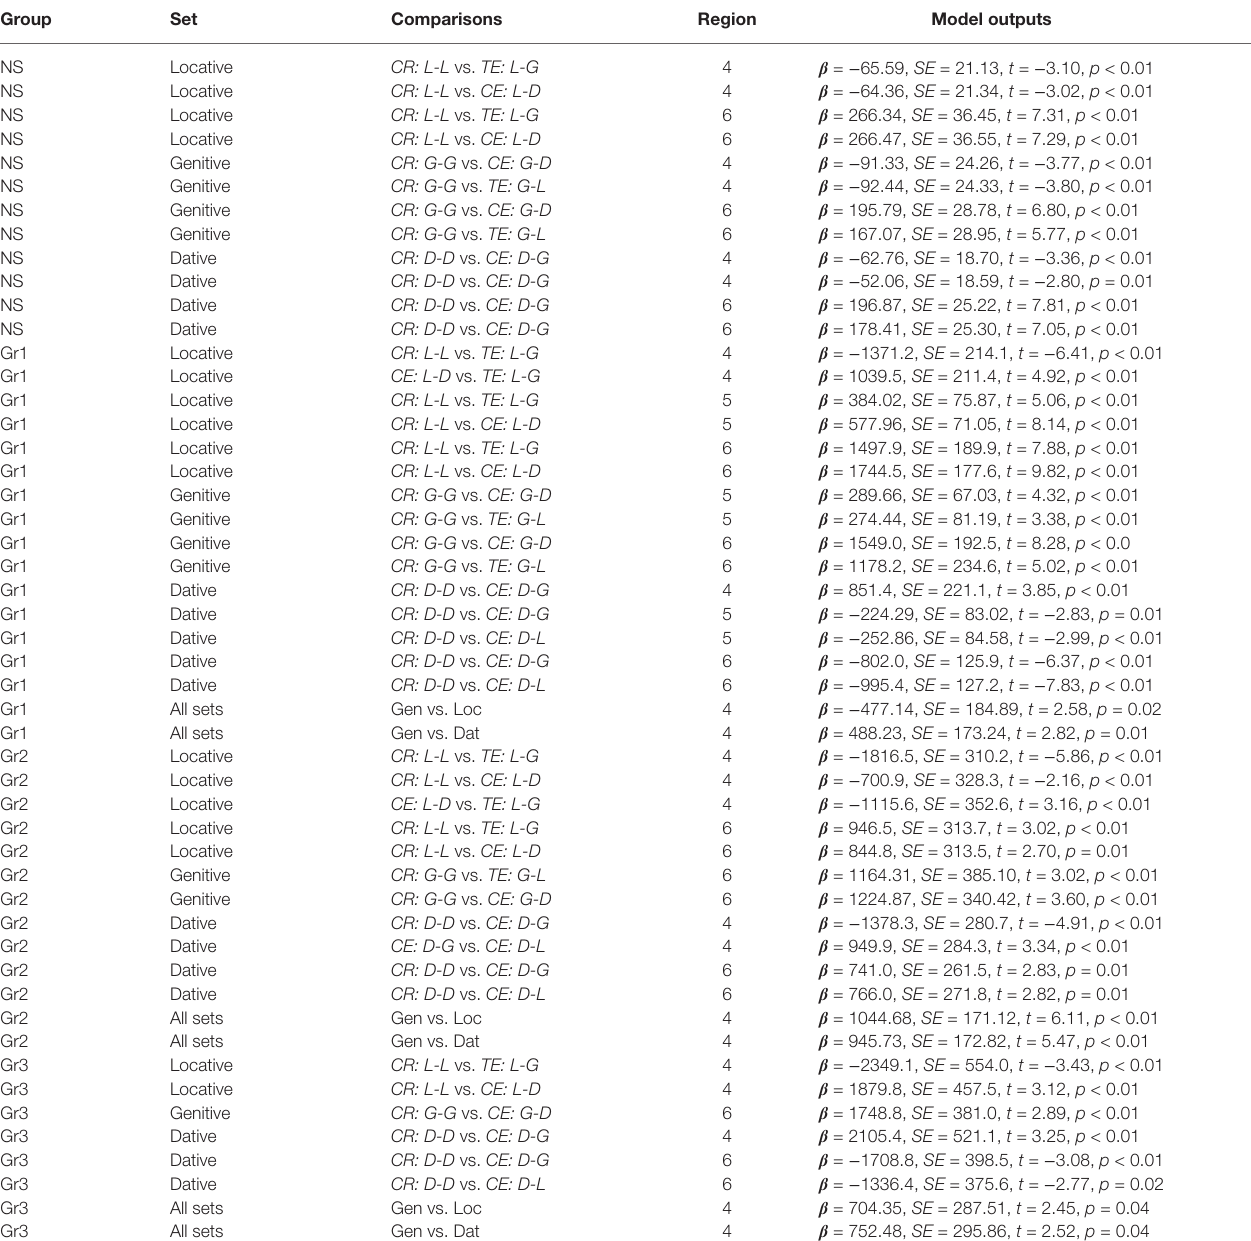
TABLE 3 | Model outputs for RT analyzes in different conditions.